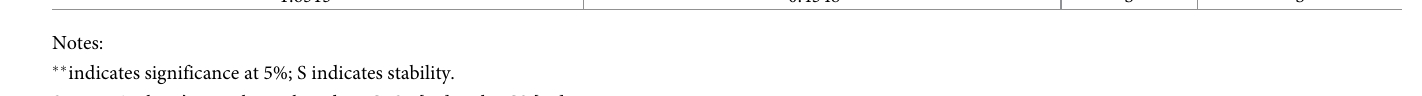
Table 3. Results of post estimation diagnostic and stability tests. Durbin-Watson Statistic Test (Ho: No serial